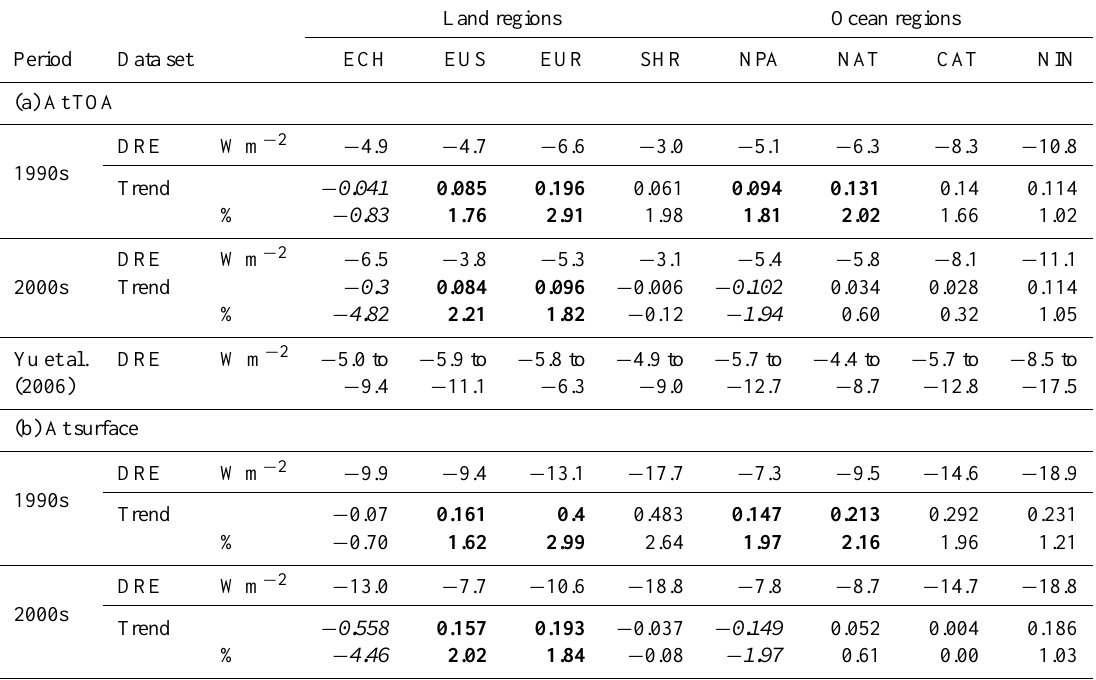
Table 4. Estimates of 24h-mean JJA-averaged aerosol direct radiative effect (DRE) and its trends. Land regions Ocean